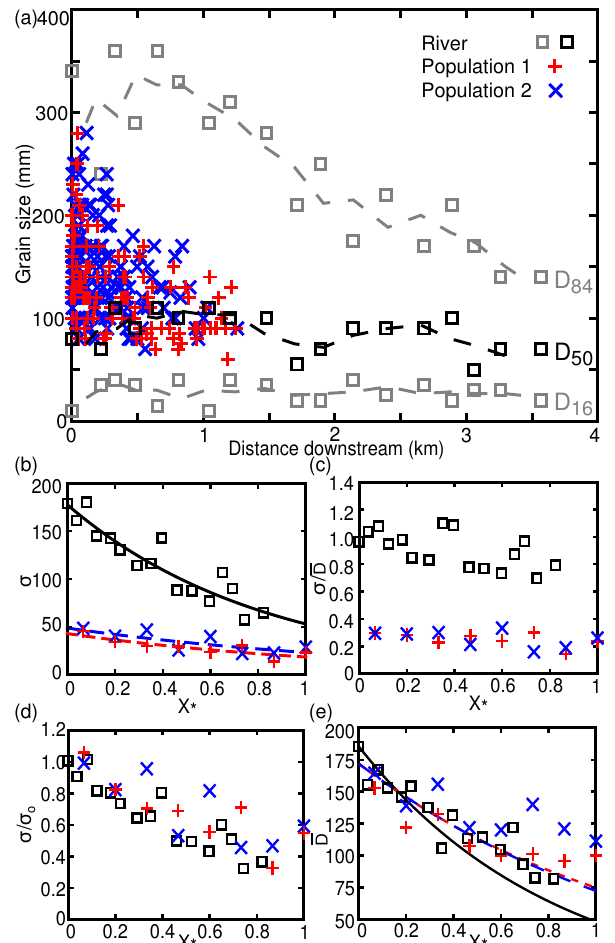
Figure 12. (a) Tracer grain size (mm) against distance (km) the particle has traveled for the first (red + ) and second (blue x) tracer populations at the final survey. Black and gray squares represent the grain size percentiles at the corresponding distance downstream for the river. The dashed lines are moving averages to guide the eye. (b) Spatial standard deviation for the river, and both populations of tracer particles against dimensionless distance ( X ∗ ). The lines rep- resent fitted exponential functions with the form of Eq. (3) with co- efficients 185, 43, and 49 and exponents 1.2, 0.83, and 0.73 for the stream, population 1, and population 2, respectively. (c) Coefficient of variation moving downstream for the river and both populations of tracer particles. (d) Collapse of the stream and tracer populations standard deviation data. σ o represents the coefficients from the fit- ted equations in (b) . (e) Downstream decrease in the mean ( D ) grain size. Lines represent Eq.